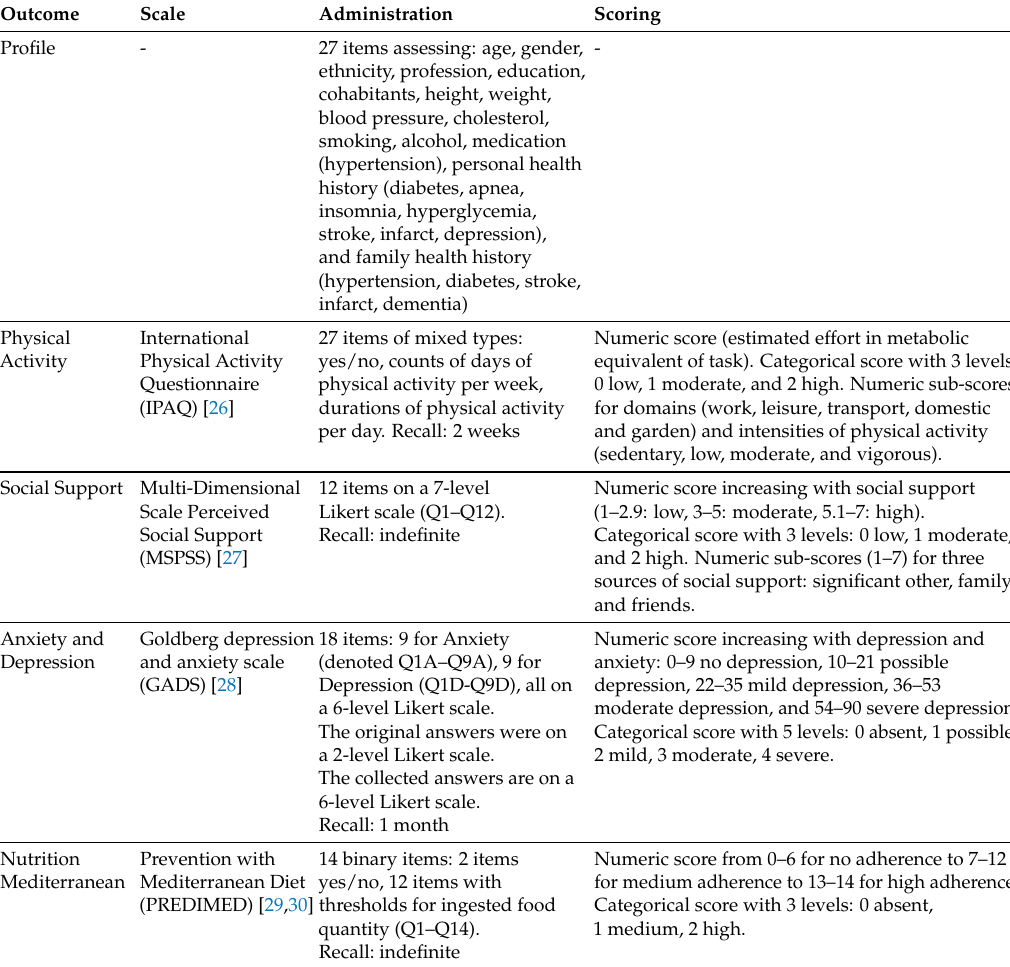
Table A1. Questionnaires with validated scales for